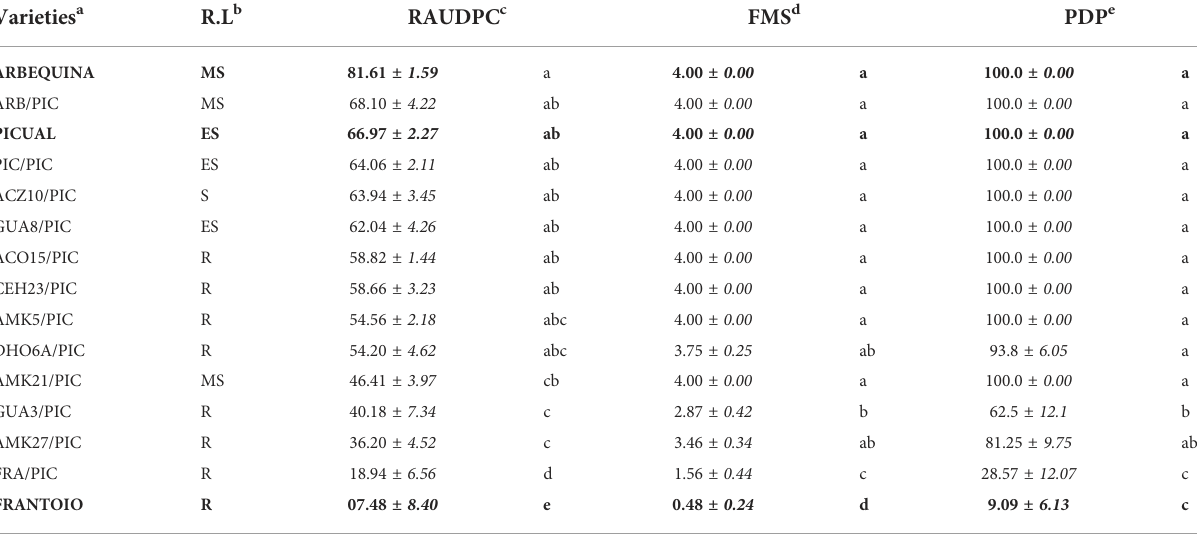
TABLE 1 Mean disease parameters assessed in cultivar ‘ Picual ’ grafted onto wild olive rootstocks inoculated with the defoliating isolate VD117 of Verticillium dahliae. Varieties a